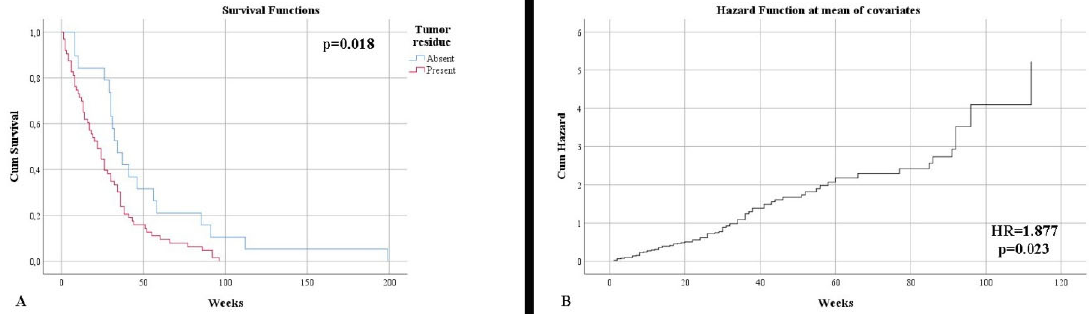
Figure 2. ( A ) Kaplan–Meier survival graphic that shows a lower survival rate for patients with the presence of tumor residue. ( B ) Univariate cox regression analysis that demonstrates the risk of death in presence of tumor residue. Table 2. Stratification after diagnosis of the main aspects identified by imaging tests.